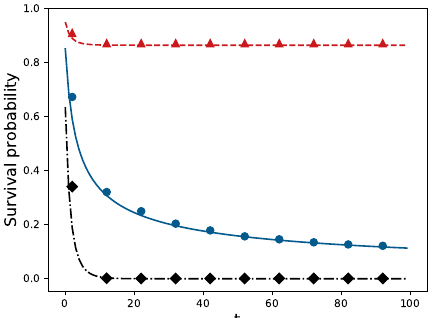
Figure 4. The survival probability for the one-dimensional search with drift for D = 1, V = 0, and X − x 0 = 2 (blue solid line), V = 1 and X − x 0 = − 2 (red dashed line), and V = 1 and X − x 0 = 2 (black dot-dashed line). The numerical results are represented by dots, triangles, and